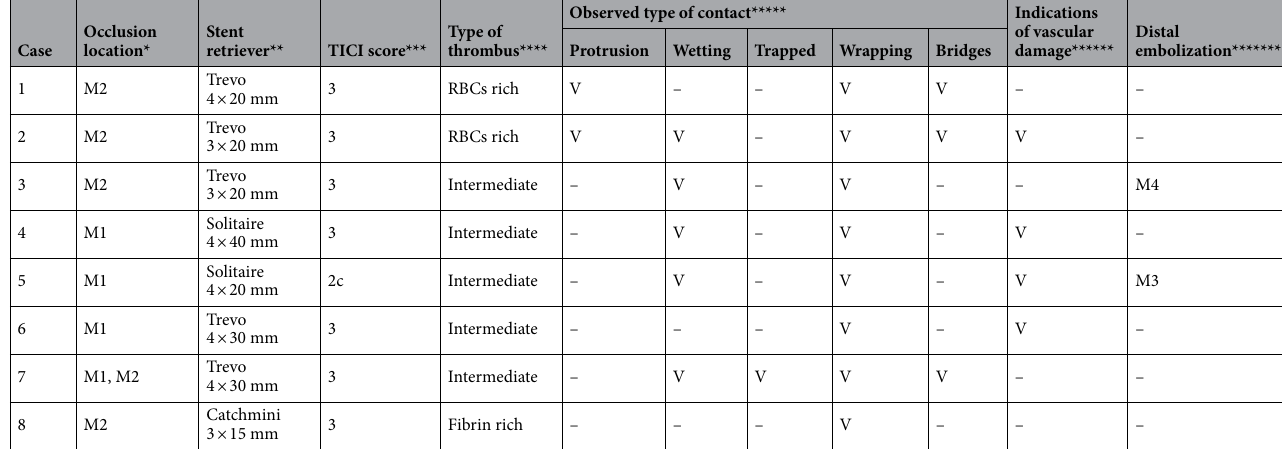
securing the thrombus attachment.